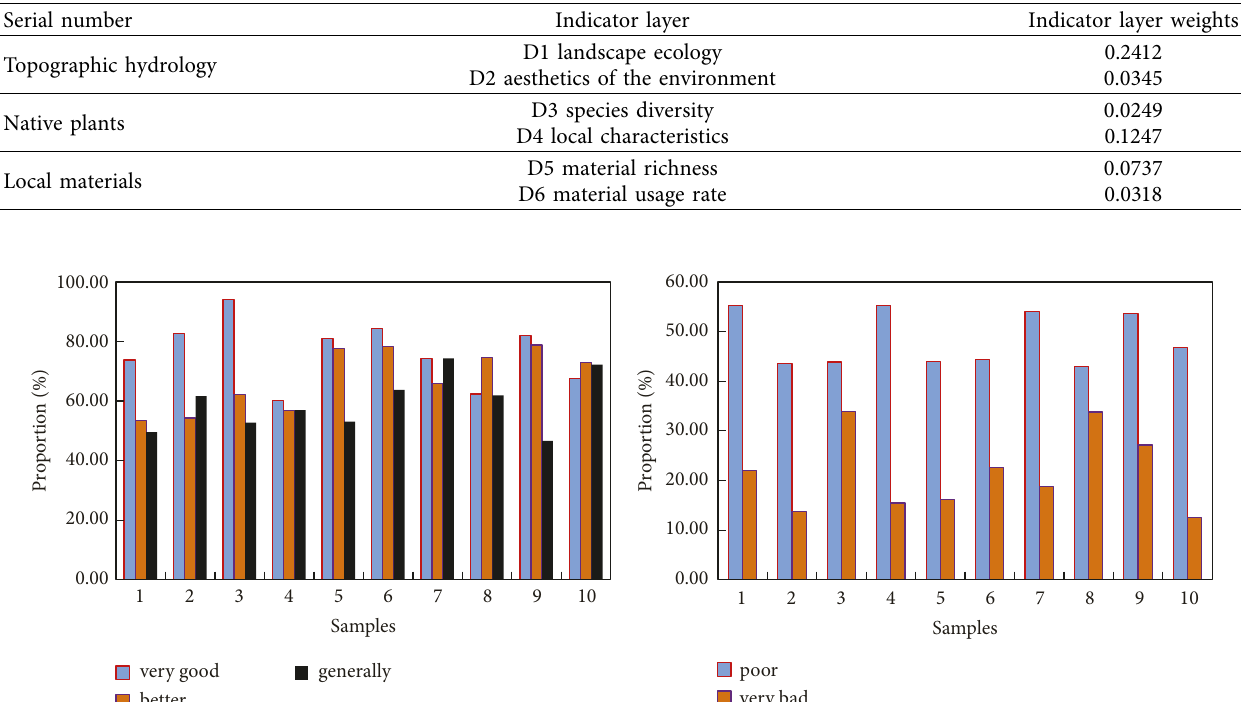
Table 6: Comprehensive weights of ecological effect factors.